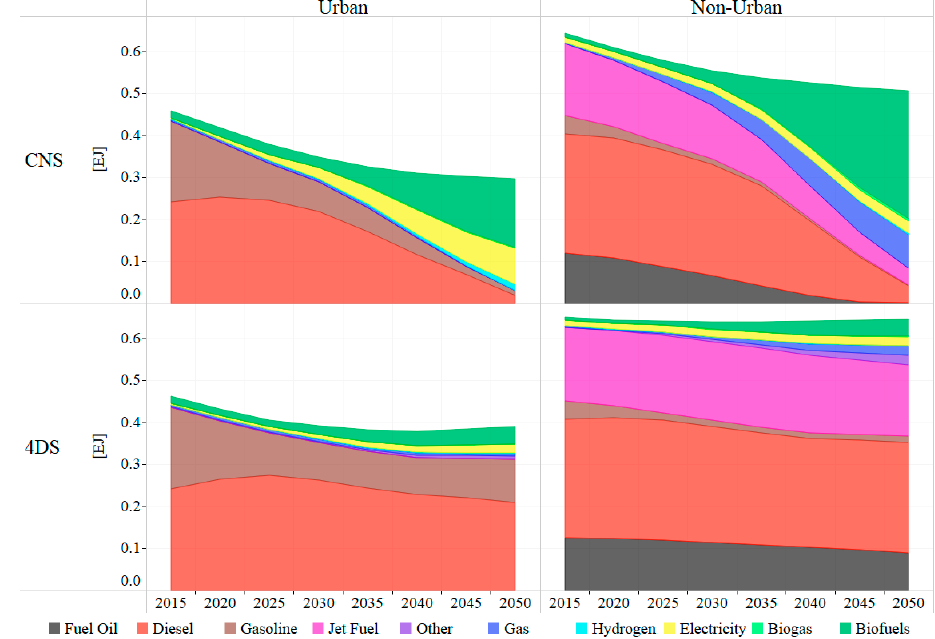
Figure 1. Nordic transport final energy demand (EJ) in urban and non-urban areas. Including international aviation and shipping, excluding pipeline transport. Results from MoMo, provided by [44], are interpolated with a five-year step resolution. “Biofuels” includes ethanol, biodiesel, bio oil, and bio jet fuel, while “Other” includes gas- and coal-to-liquid fuels.